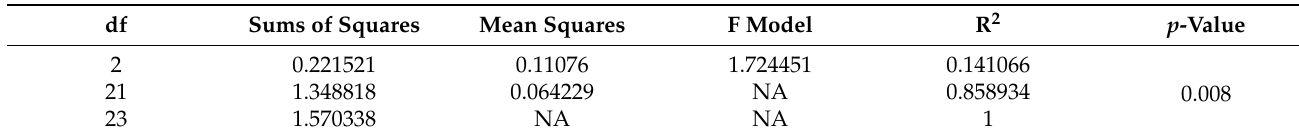
Table A2. Pairwise Adonis comparison of the 16S bacterial genus abundance among the Control, DOCA, and DOCA + Captopril groups.